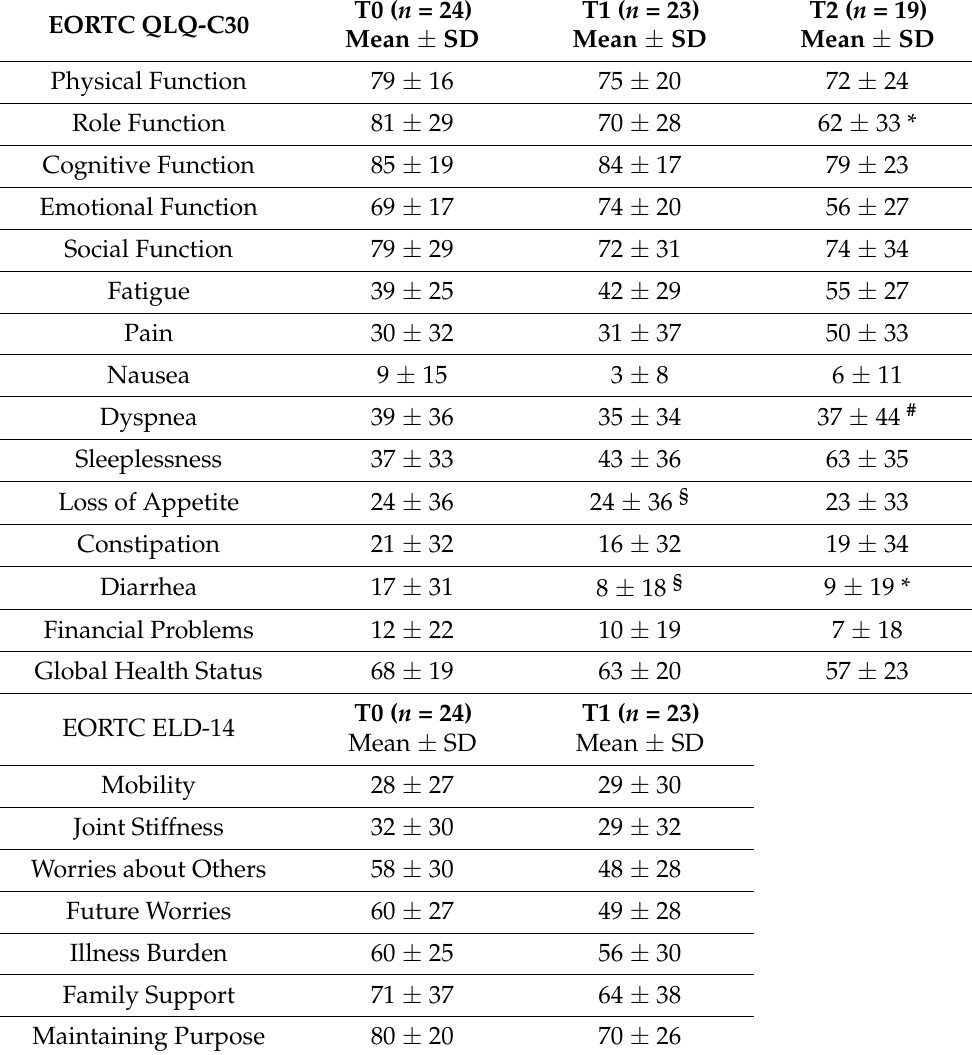
Table 4. Mean values (MV) and standard deviations (SD) for all functioning scales and symptom scales of the EORTC QLQ-C30 and EORTC ELD-14 over